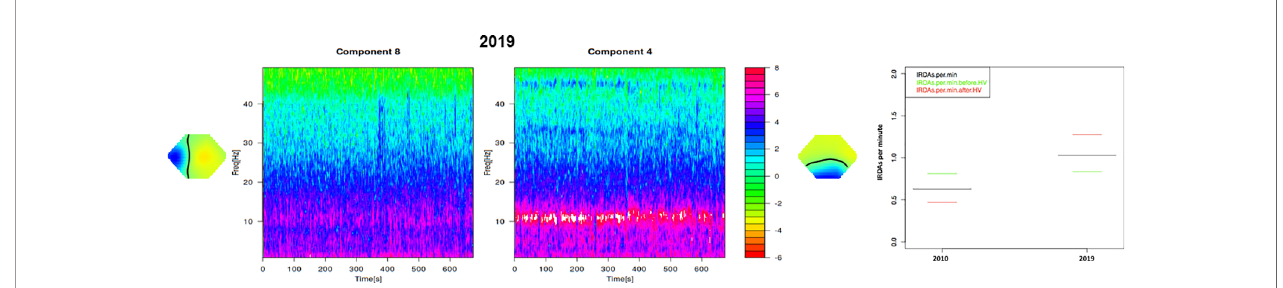
FIGURE 3 | Electroencephalography (EEG) analysis using independent component analysis (ICA, left) and intermittent rhythmic delta activity (IRDA) rates (right). The follow-up EEG analysis in 2019 showed strong a -activity and some IRDAs in component 4 and 8 (left). The left-temporal component (8) contains individual spike wave complexes. Overall, there was an increase in IRDA rates from 2010 to